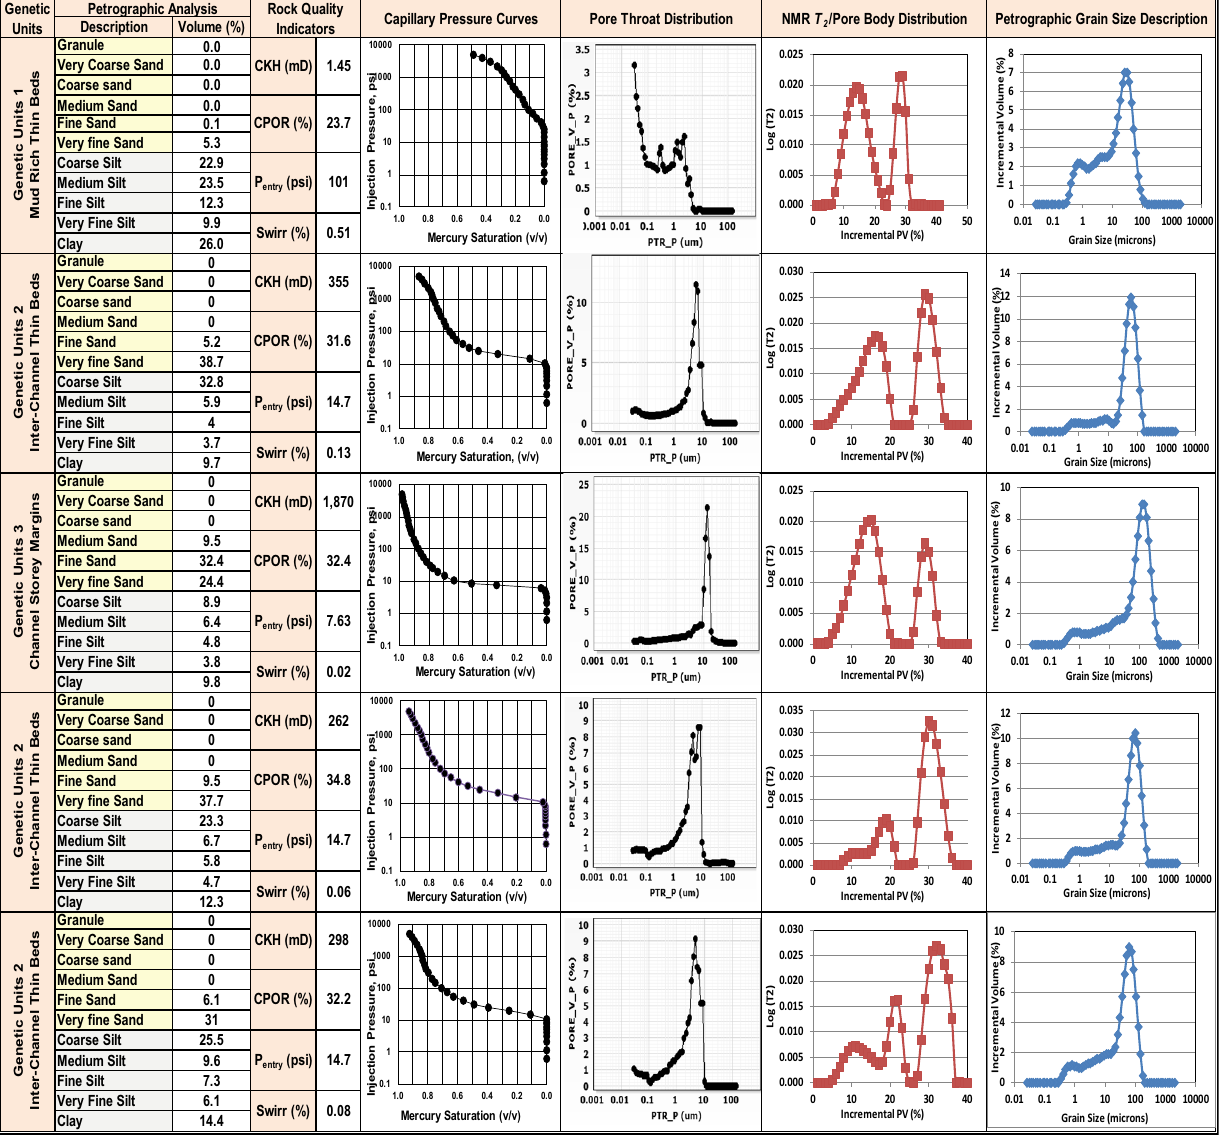
Petrographic Grain Size